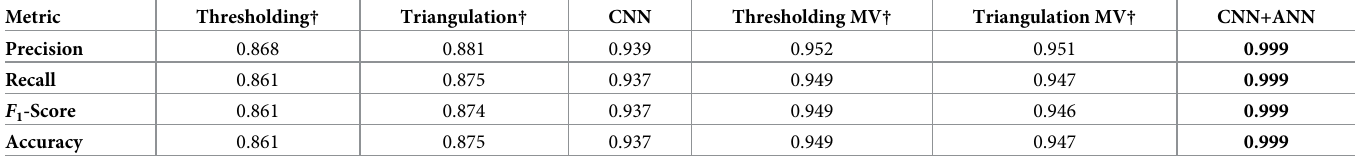
Table 1. Classification results for each method. The scores for the precision, recall, F 1 -score, and accuracy metrics are shown for all four classification methods. The method with the highest score for each metric is highlighted in bold. The (†) symbol by the thresholding methods indicates that these methods only classified 18 zones, whereas the neural network methods classified 21